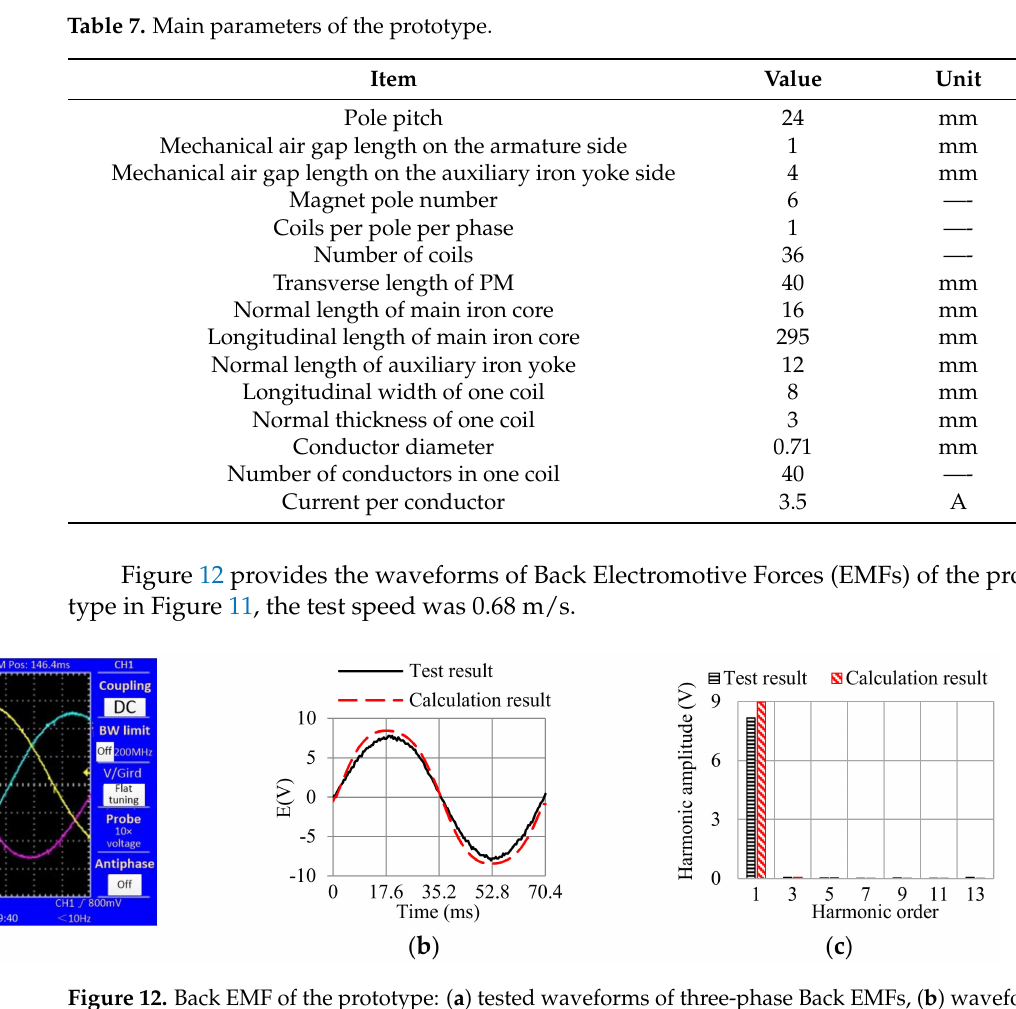
Figure 12. Back EMF of the prototype: ( a ) tested waveforms of three-phase Back EMFs, ( b ) waveform comparison of the test result and the calculation result, ( c ) harmonic contents of the test result and the calculation result.